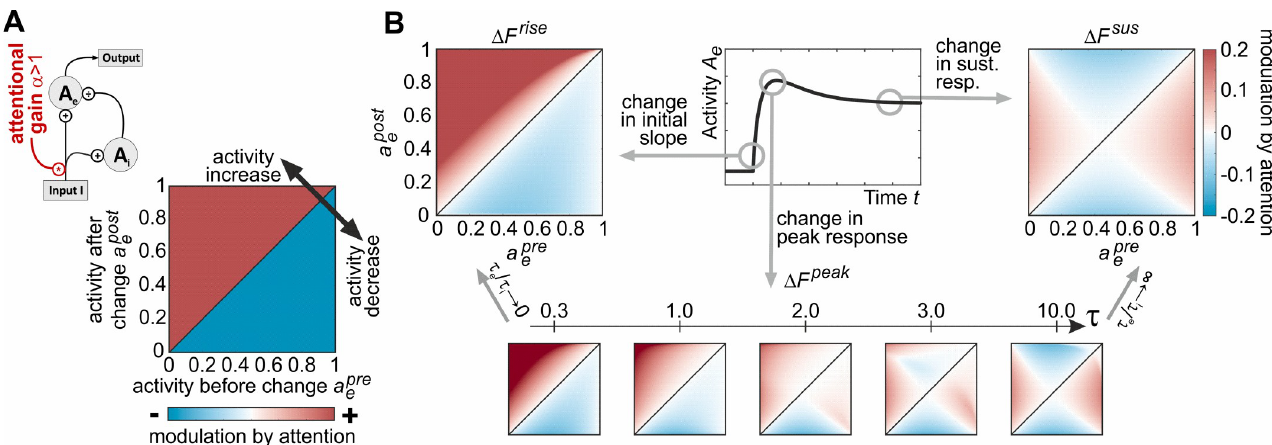
Fig 4. Model predictions for attention-induced changes in slope, peak, and sustained responses. (A) Attention is included into the model by a simple multiplicative gain change of the input (top left schematic). Ideally, attention should elicit a consistent modulation of the neuronal change response, as e.g. enhancing a neural response feature for positive input changes (above diagonal, red shading), and suppressing it for negative input changes (below diagonal, blue shading) irrespective of the particular pre-change activation level. (B) Predicted attention-dependent changes in slope Δ F rise (top left, indicating consistent modulation by attention), sustained activation Δ F sus (top right, indicating inconsistent, pre-change activation-dependent modulation by attention), and relative peak height Δ F peak (bottom plots). Relative peak height critically depends on the time scale ratio τ Δ F sus for τ e / τ i !1 . Axes and color scales are identical for all plots in (B), indicated at the top left and right chart.